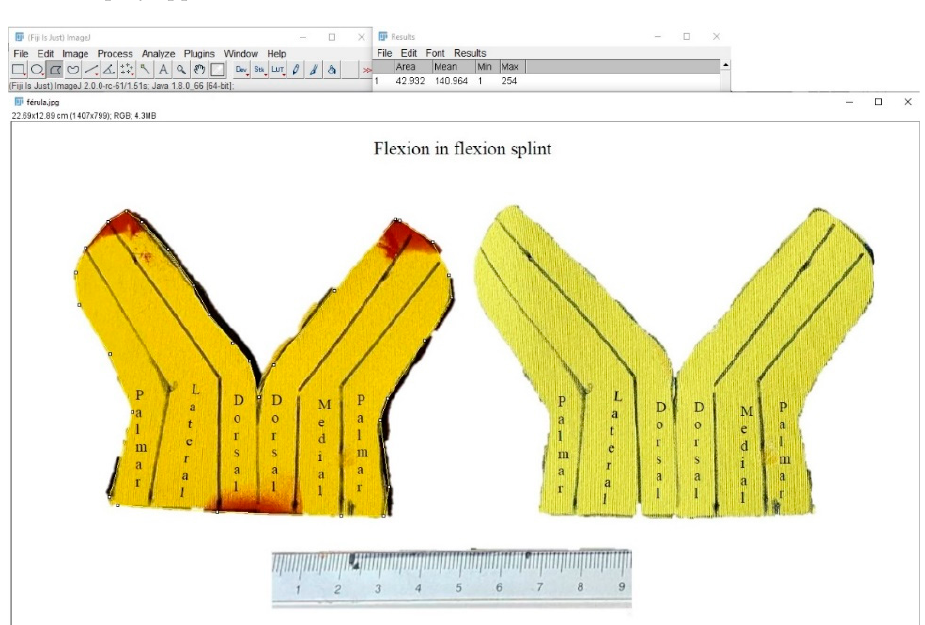
Figure 9. Measurement of super fi cial area in software Fiji-ImageJ.